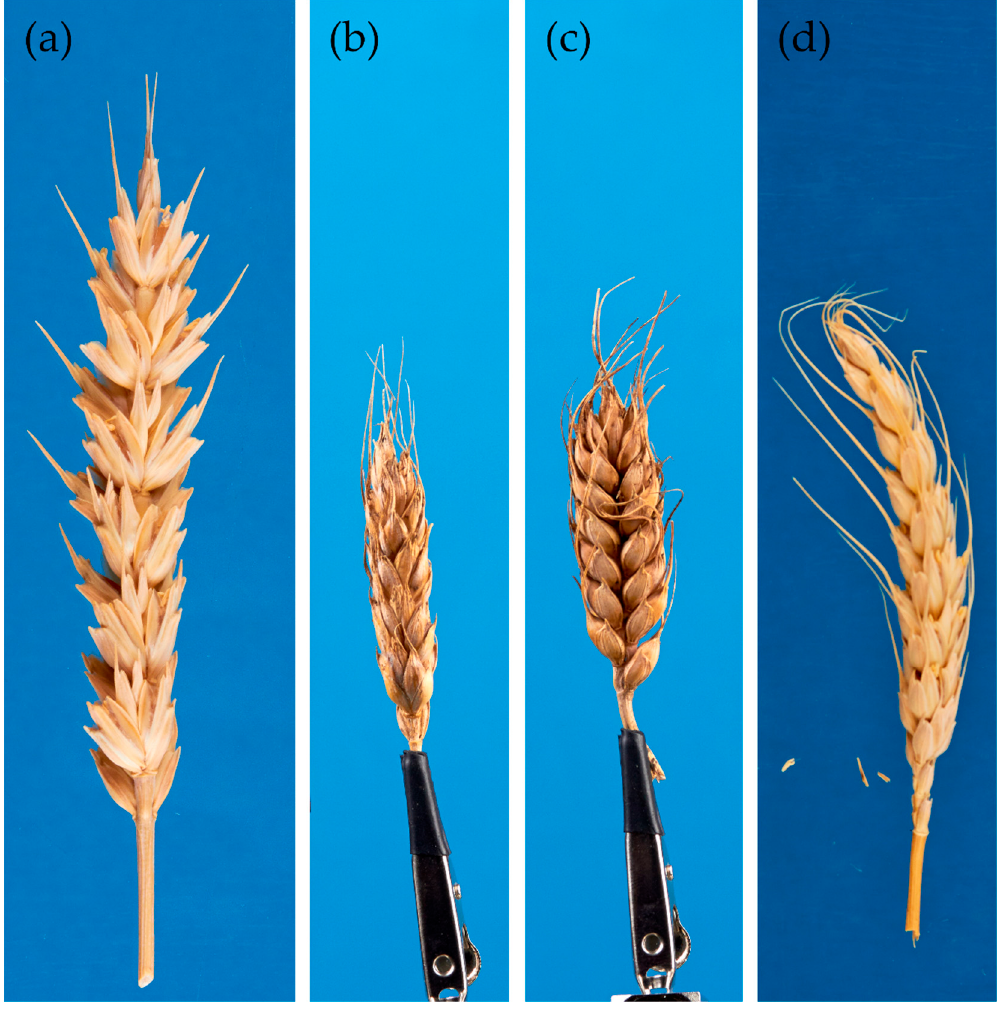
Figure2. Awnednesstypesofspikes: ( a )awnless, ( b )awnletted, ( c )half-awned, and( d Figure 2. Awnedness types of spikes: ( a ) awnless, ( b ) awnletted, ( c ) half-awned, and ( d ) and short-awned.